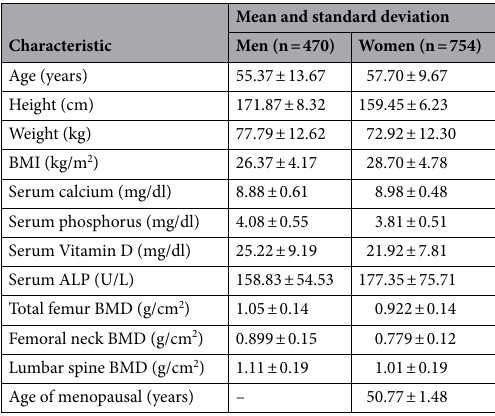
Table 3. Demographic information of male and female